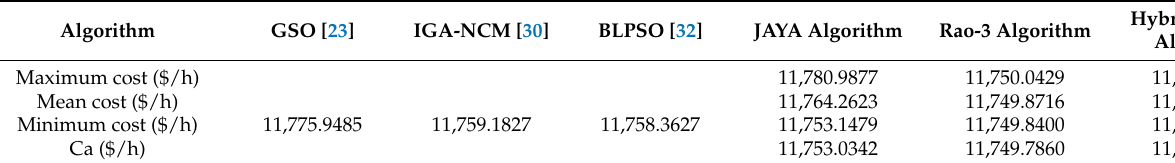
Table 2. Statistical analysis of test system 1.